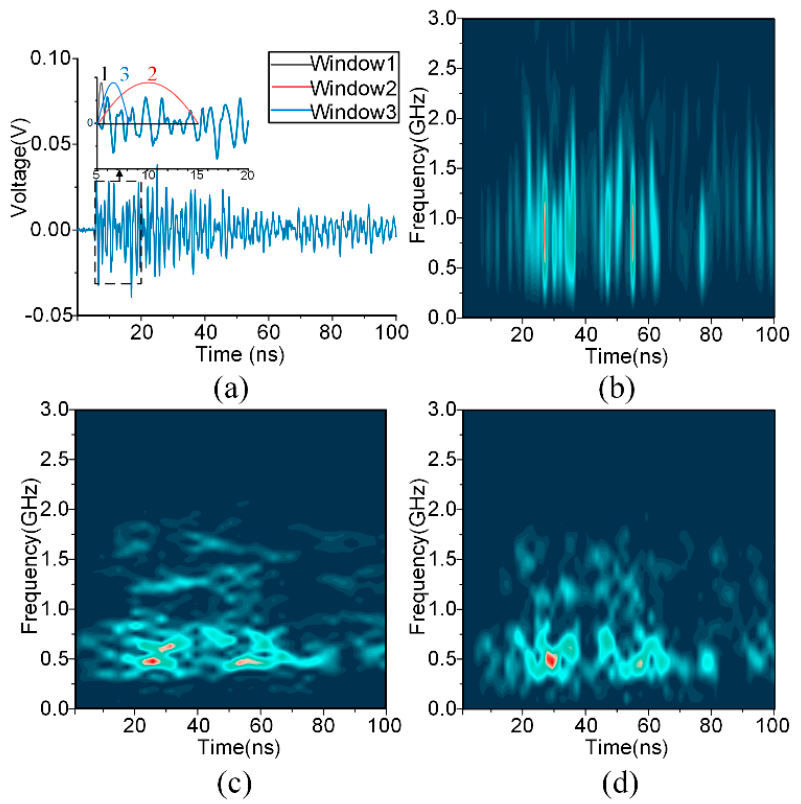
Figure 1. Gabor representations of different time and frequency resolutions: ( a ) windows of different lengths; ( b ) spectrogram of higher time resolution; ( c ) spectrogram of higher frequency resolution; ( d ) spectrum of medium resolution.